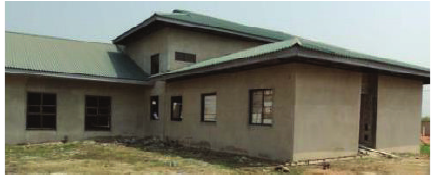
Figure 4: An unpainted office building of Electricity Corporation of Ghana (ECG) at Kentinkrono in Kumasi, Ghana.